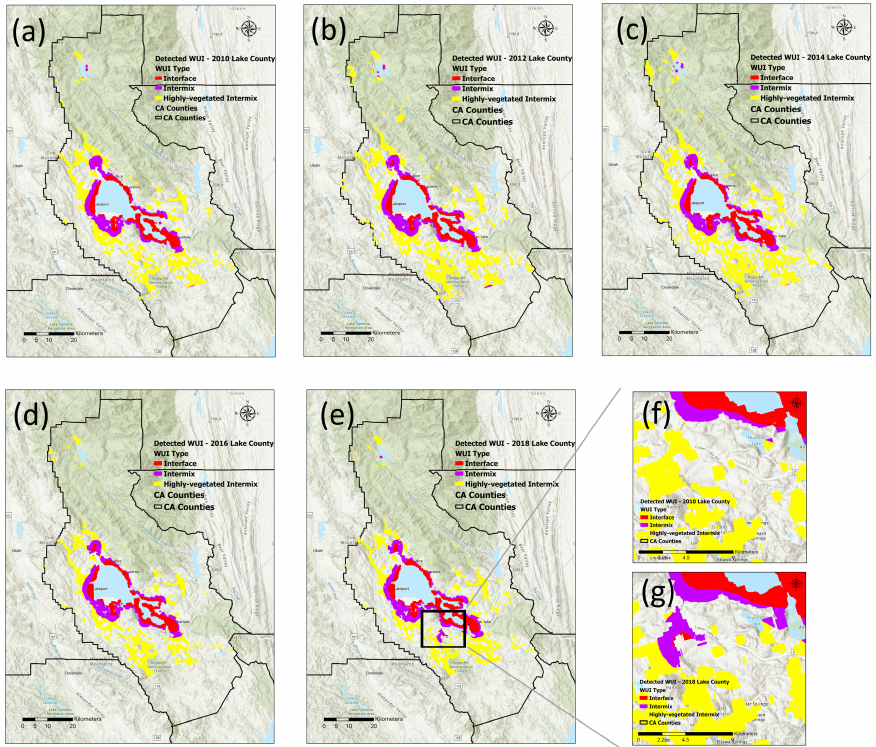
Figure 9. Changes in identified WUI areas in Lake County from 2010 to 2018 ( a – e ). Closeups are also shown for a subset region in 2010 ( f ) and 2018 ( g ).